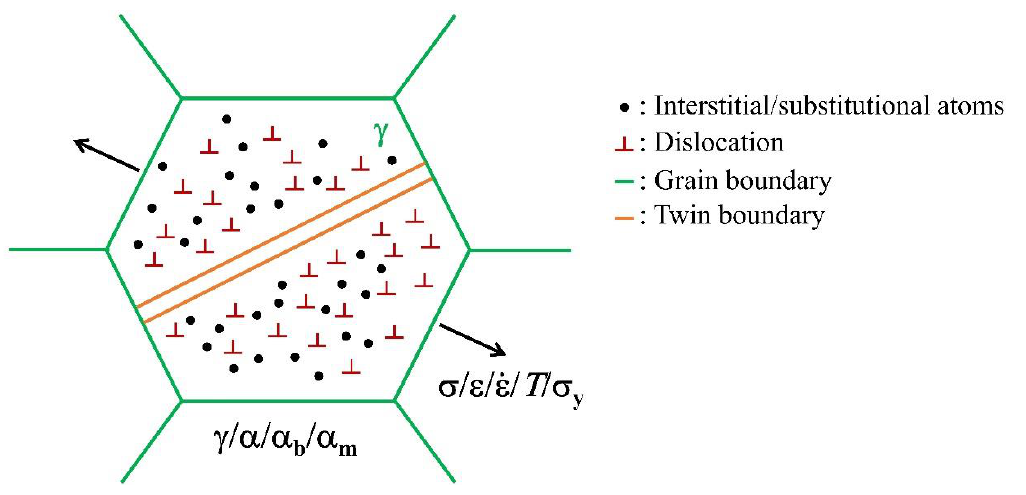
Figure 1. Schematic illustration of the intrinsic and extrinsic factors in governing the austenite stability. γ : austenite; α : ferrite; α b : bainite; α m : martensite; σ : stress; ε : strain, ɛ̇ : strain rate; T : temperature; σ y : yield strength.